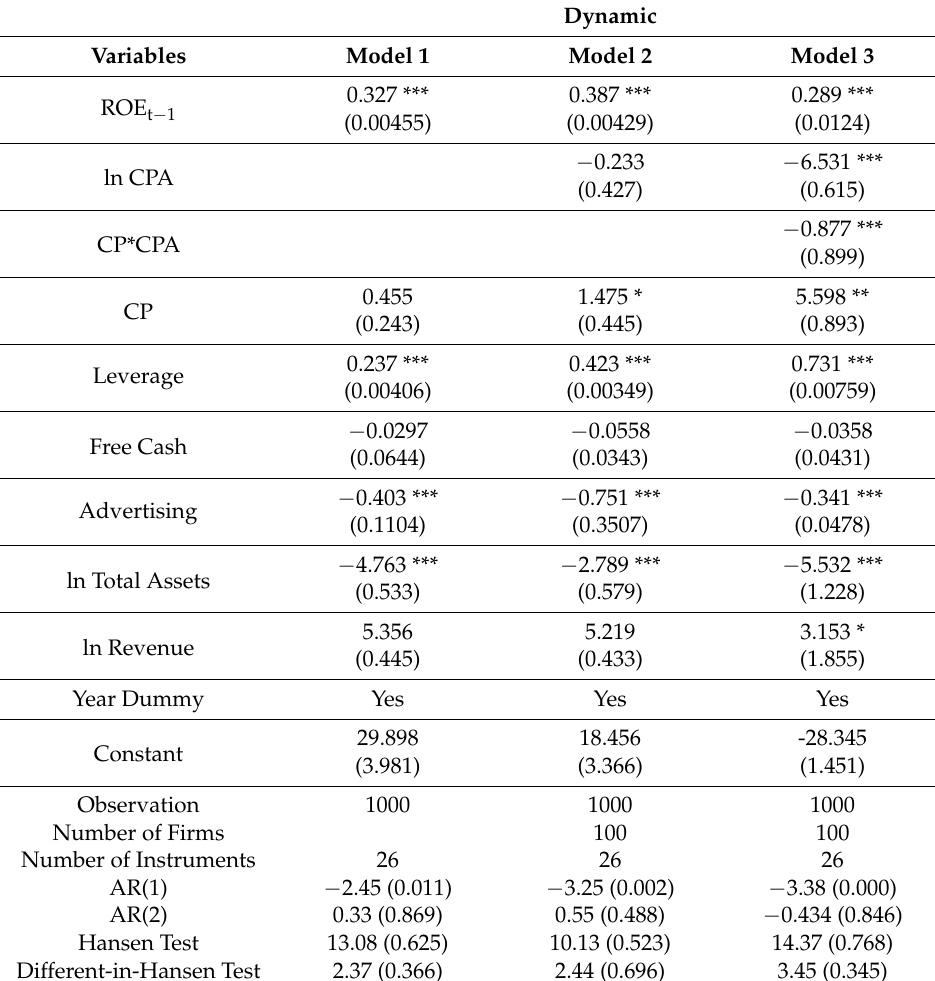
Table 6. The Moderating Effect of CP on CPA and Firm Performance